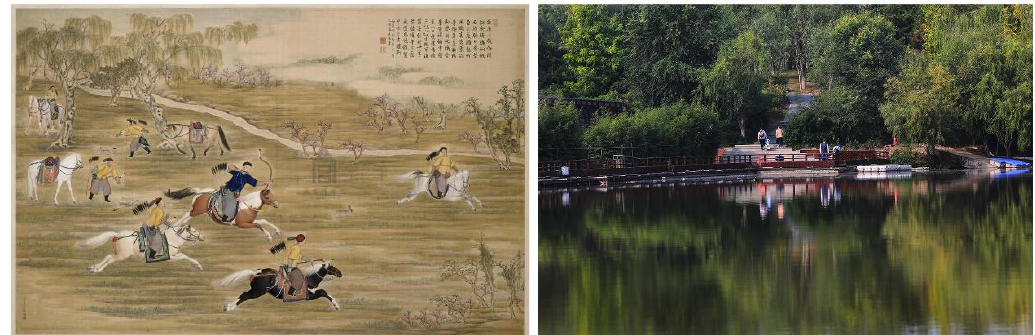
Figure 3. Historical changes of Nanyuan (a royal hunting ground), see the left for the Qianlong emperor hunting scenes in Nanyuan (the picture of Emperor Qianlong shooting, collected from the Palace Museum) [8], and the right for present day Nanyuan, renamed the Nanhaizi Country Park [9].